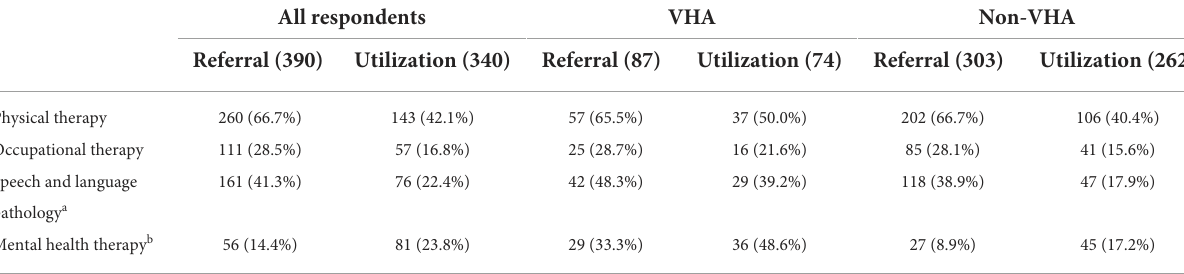
TABLE 4 Referral and utilization rates for Veterans receiving Services at the VHA and elsewhere.